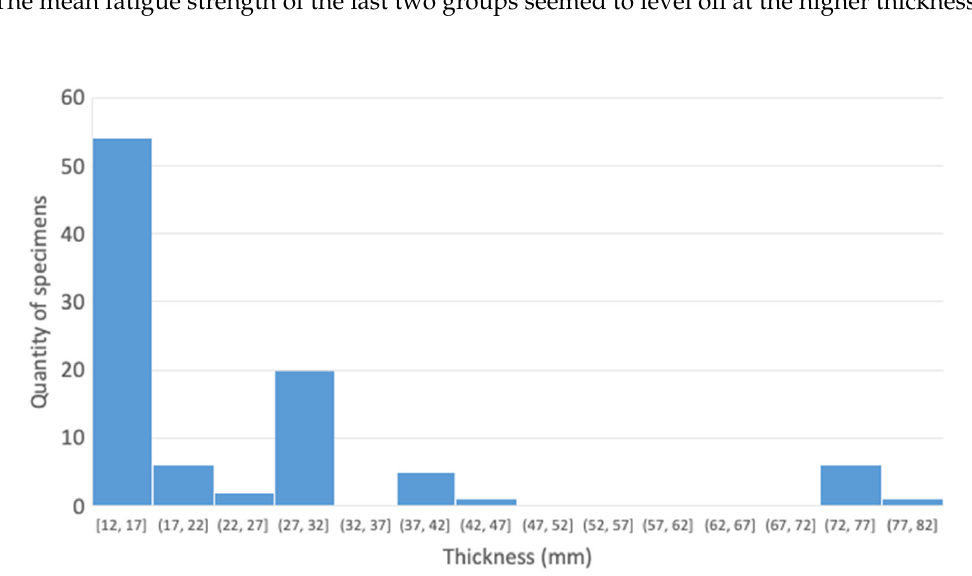
Figure 17. Histogram of thickness with in-air tubular joint Figure 19. Histogram of thickness with in-air tubular joint samples . Figure 19. Histogram of thickness with in-air tubular joint samples .